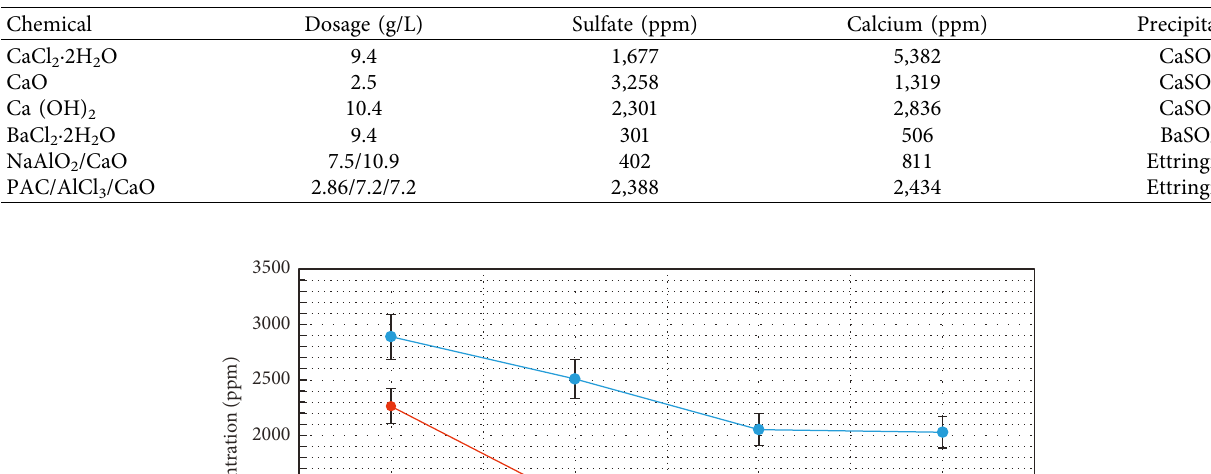
4 , BaSO 4 , and ettringite precipitation methods.